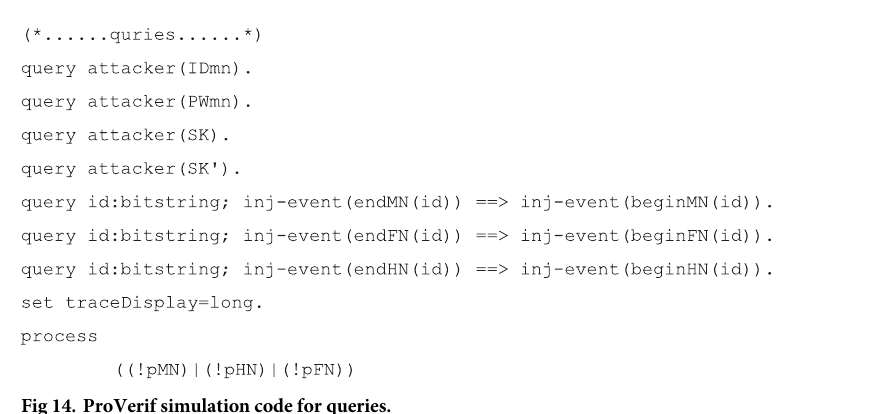
Fig 14. ProVerif simulation code for queries.